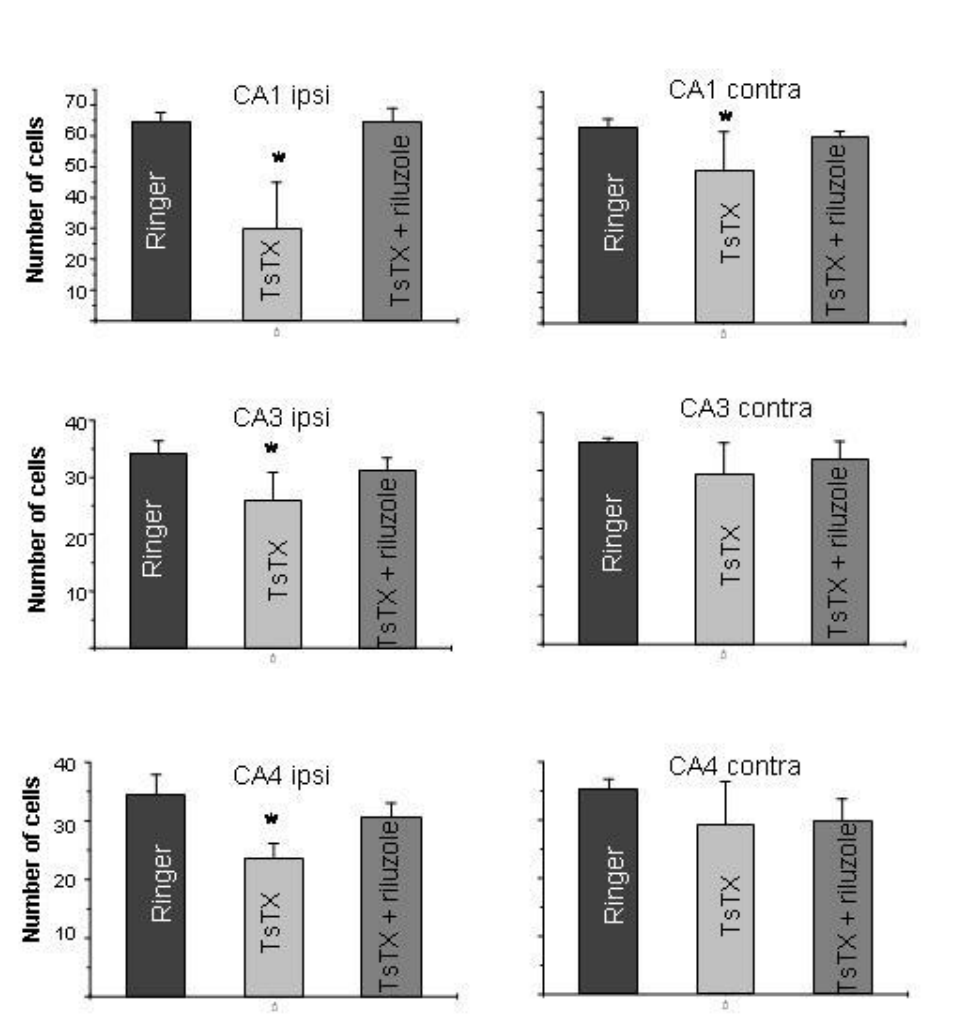
Figure 3. Number of cells in the ipsilateral and contralateral CA1, CA3 and CA4 areas of the hippocampus after intrahippocampal injection of 2 µg TsTX, both in the presence and absence of riluzole (5 mg/kg). Rats were killed seven days after the inoculation. Error bars indicate standard deviation p < 0.05 compared to control group (Ringer) and Tukey’s test. All groups n =